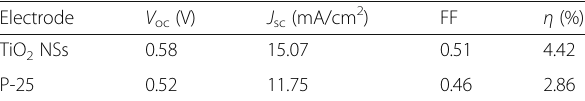
Table 2 Photovoltaic properties of the TiO 2 NS- and P-25-based QDSSCs Electrode